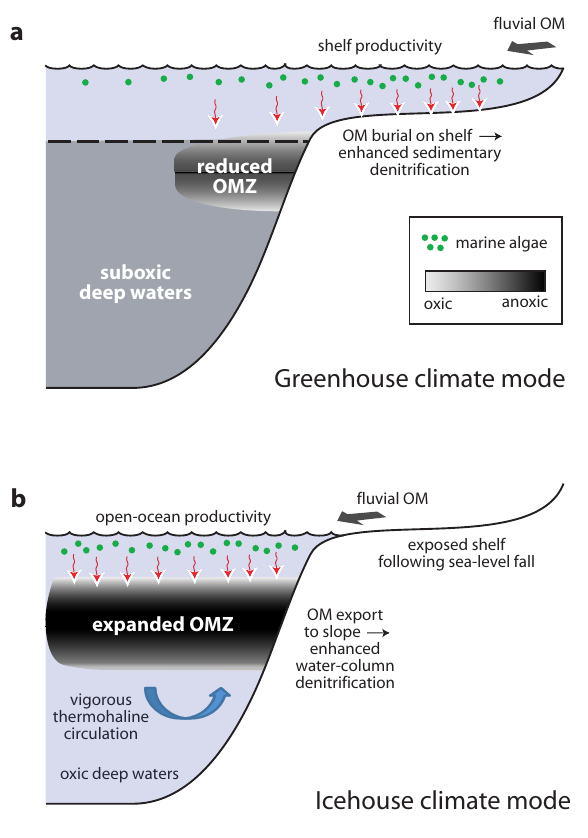
Fig. 9. Model for eustatic control of long-term δ 15 N sed variation. (a) Greenhouse climate mode. High eustatic levels result in on-shelf marine productivity and delivery of fluvial organic matter (OM) to shelf environments. Large quantities of OM are trapped in shelf sed- iments, enhancing sedimentary denitrification. (b) Icehouse climate mode. Low eustatic levels result in open-ocean productivity and de- livery of fluvial OM to shelf margins. The sinking flux of OM to the thermocline is elevated, leading to expansion of the oxygen- minimum zone (OMZ) and enhanced water-column denitrification.